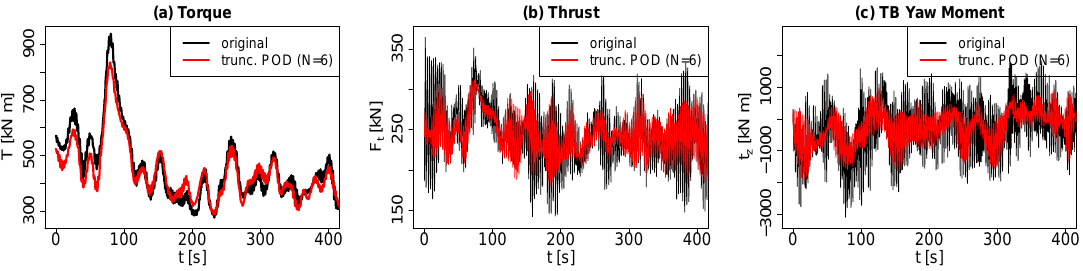
the variances of F t and t z . Less than 90% are captured for 40 modes. For the torque T , already 20 modes will give approx. 100%.